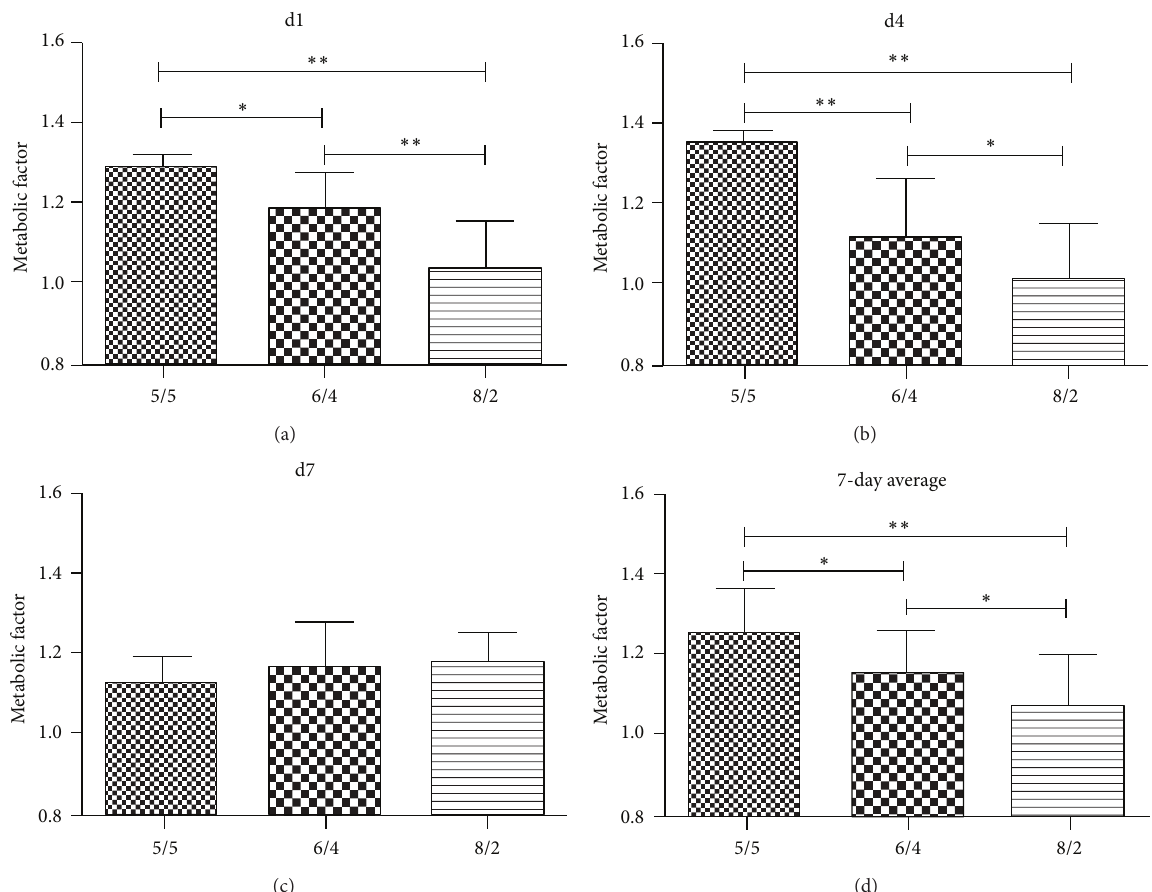
Figure 2: Metabolic factors of OEC on PU/PLDL electrospun scaffolds of various PU/PLDL w/w ratios after 1, 4, and 7 days in culture (graphs a, b, and c, resp.), and metabolic factors averaged from whole culture period (d); ∗ 𝑃 < 0.05 , ∗∗ 𝑃 < 0.01 , 𝑛 = 3